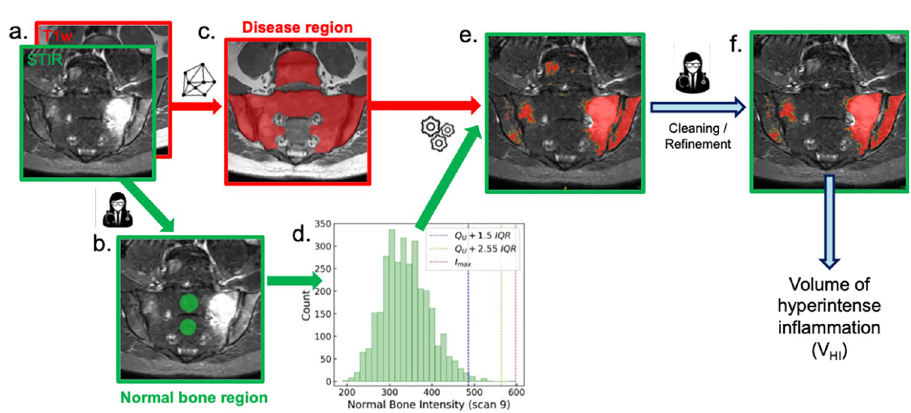
Fig 1. Schematic illustration of the proposed ‘human-machine’ workflow. A STIR image (outlined in green) and corresponding T1w image (outlined in red) (a) are used as the input. In this case, the STIR image shows left-sided sacroiliac joint inflammation. The normal bone region is manually defined by a radiologist to determine the distribution of intensity values of normal bone (b). Manual segmentation is used for this step to enable the radiologist to exercise judgement over the most representative area of normal marrow. The disease region (region of potential inflammation) is automatically segmented by a convolutional neural network to determine areas of potential disease (c). The normal bone intensity distribution is determined from the normal bone, and two thresholds are defined [the maximum of the intensity distribution (upper threshold, red dotted line) and a multiple of the interquartile range (lower threshold, orange dotted line); (a blue dotted line represents an empirical threshold value). Areas of tissue within the disease region above these thresholds are then denoted inflamed (e). Areas meeting the lower threshold alone are shown in yellow, whereas those meeting the upper threshold are shown in red. The final cleaning is performed by a radiologist to remove areas of artifact or inflammation outside the target area (f). In this example, areas of inflammation above the L5/S1 disc and in the sacroiliac joint space were removed (along with an artifactual lesion in the L5 vertebral body which was deemed to be due to a vessel) to facilitate a direct comparison with SPARCC visual